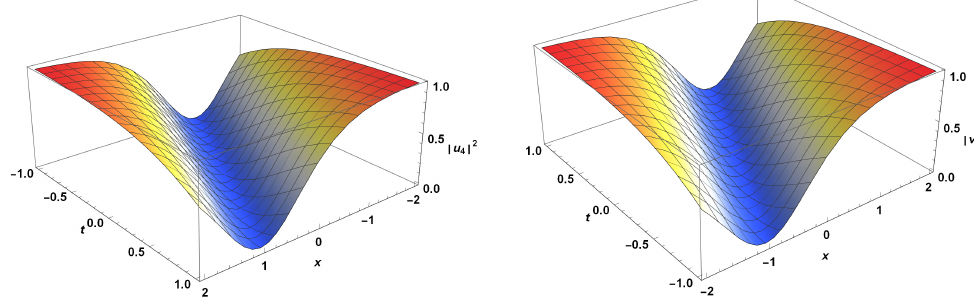
Figure 1. Surface plots of dark magneto-optic solitons (39) with e 1 = k 1 = λ 1 = θ 1 = κ = n = d 1 =